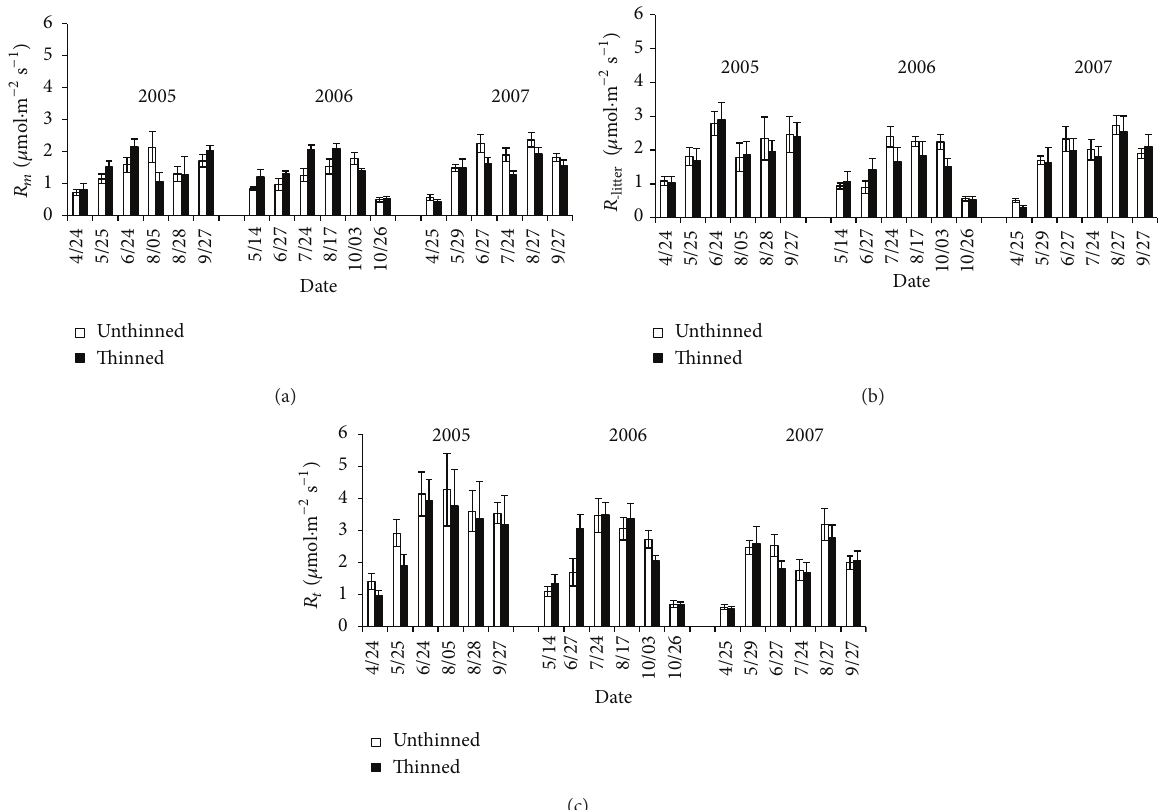
, and 𝑅 𝑡 between the unthinned and thinned sites from 2005 to 2007. (a) 𝑅 𝑚 , (b) 𝑅 − litter